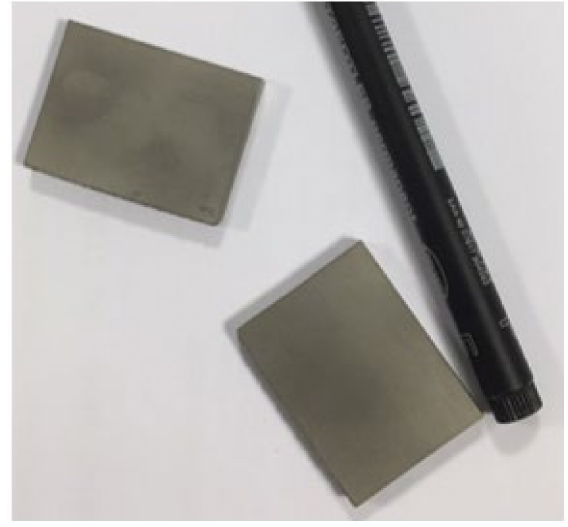
Figure 3. AlTiSiN coated specimens—Set